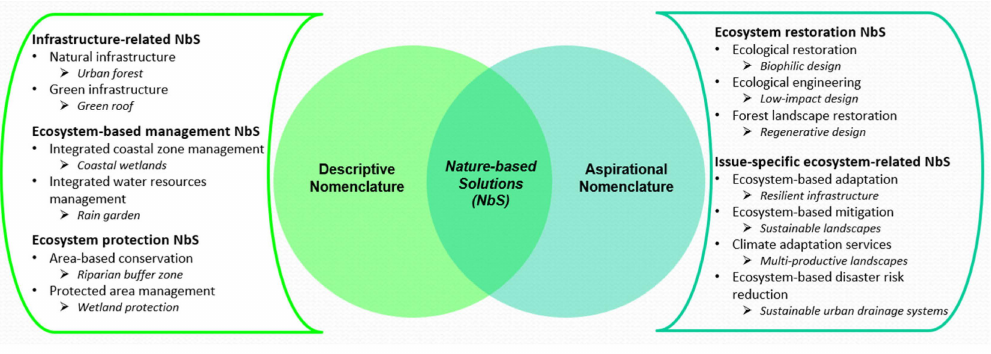
Figure 3. Examples of NbS nomenclature and naming conventions [8,50]. NbS occur at the nexus of both descriptive and aspirational categorization.